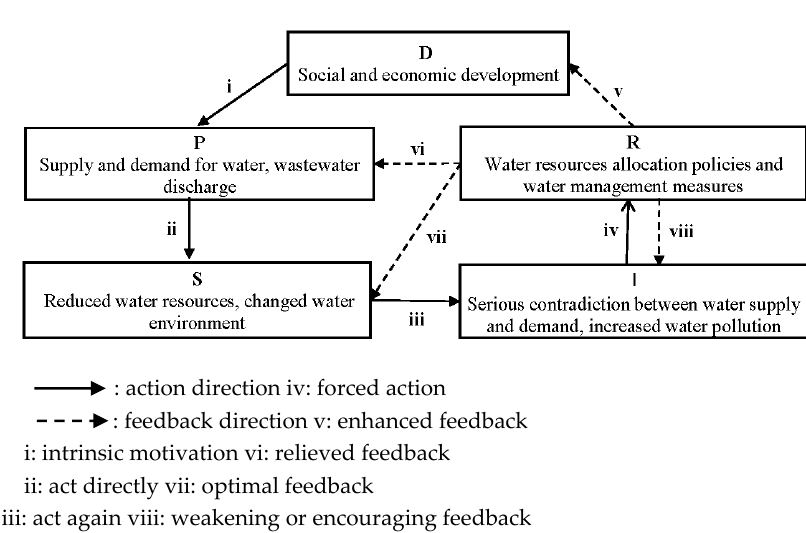
Figure 2. Driving-pressure-state-impact-response (DPSIR) feedback loop in water resource carrying capacity (WRCC).